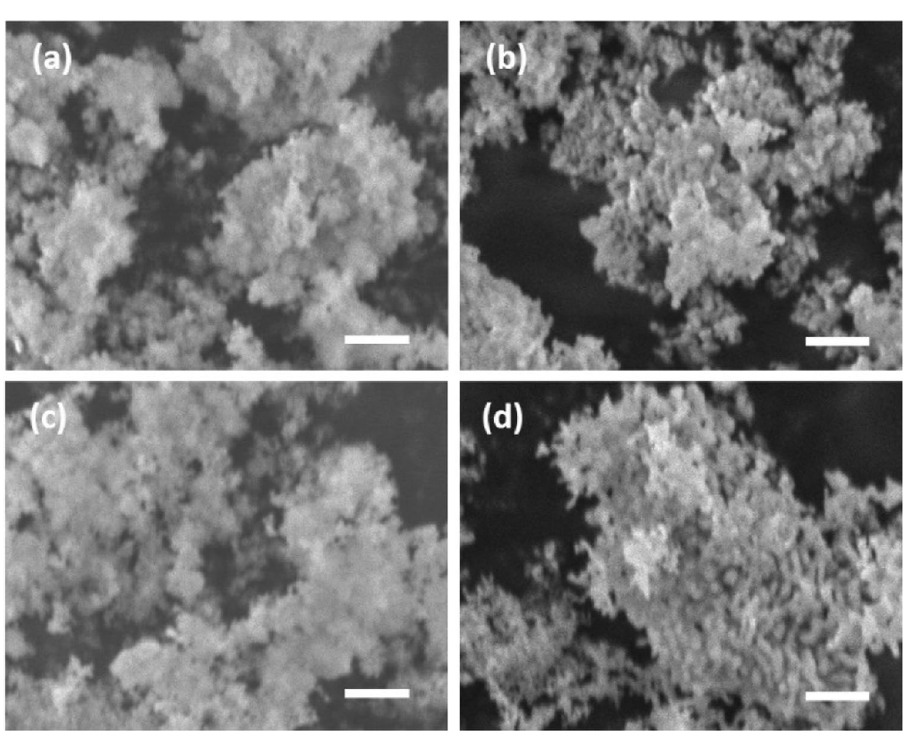
Figure 2. Typical SEM images of the particles phosphorylated in ( a , b ) a water and ( c , d ) an acetone system. ( a , c ) Pre-calcined and ( b , d ) calcined samples. Scale bar is 1